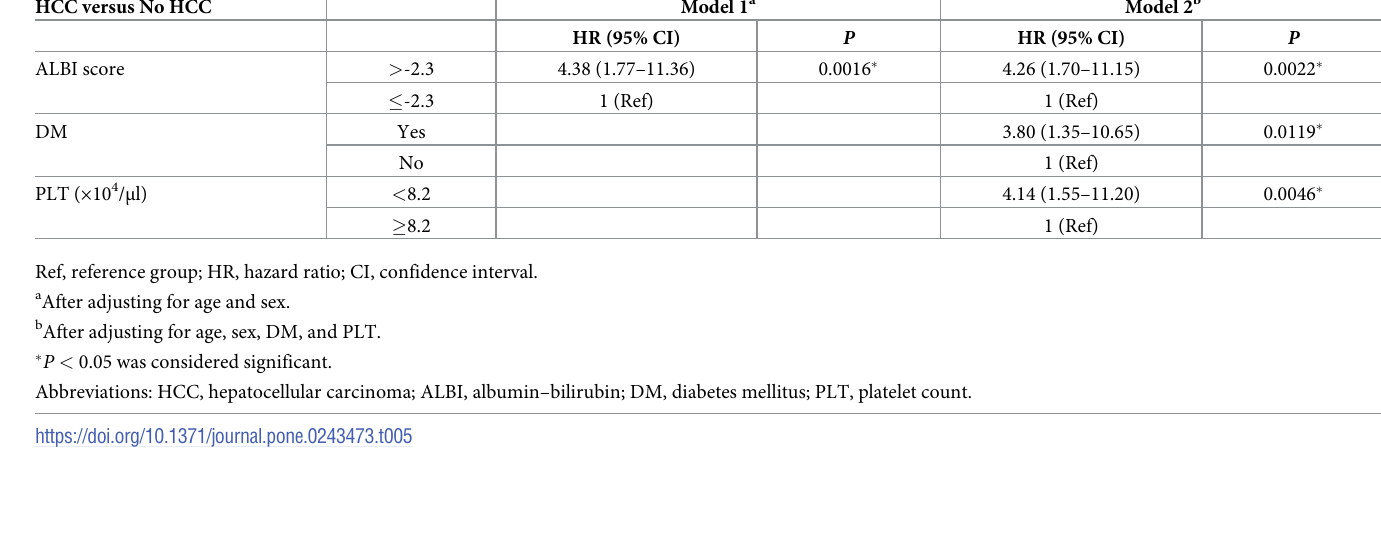
Table 5. Factors associated with the development of HCC after DAA treatment in HCV-positive patients with compensated liver cirrhosis by Cox multivariate model. HCC versus No